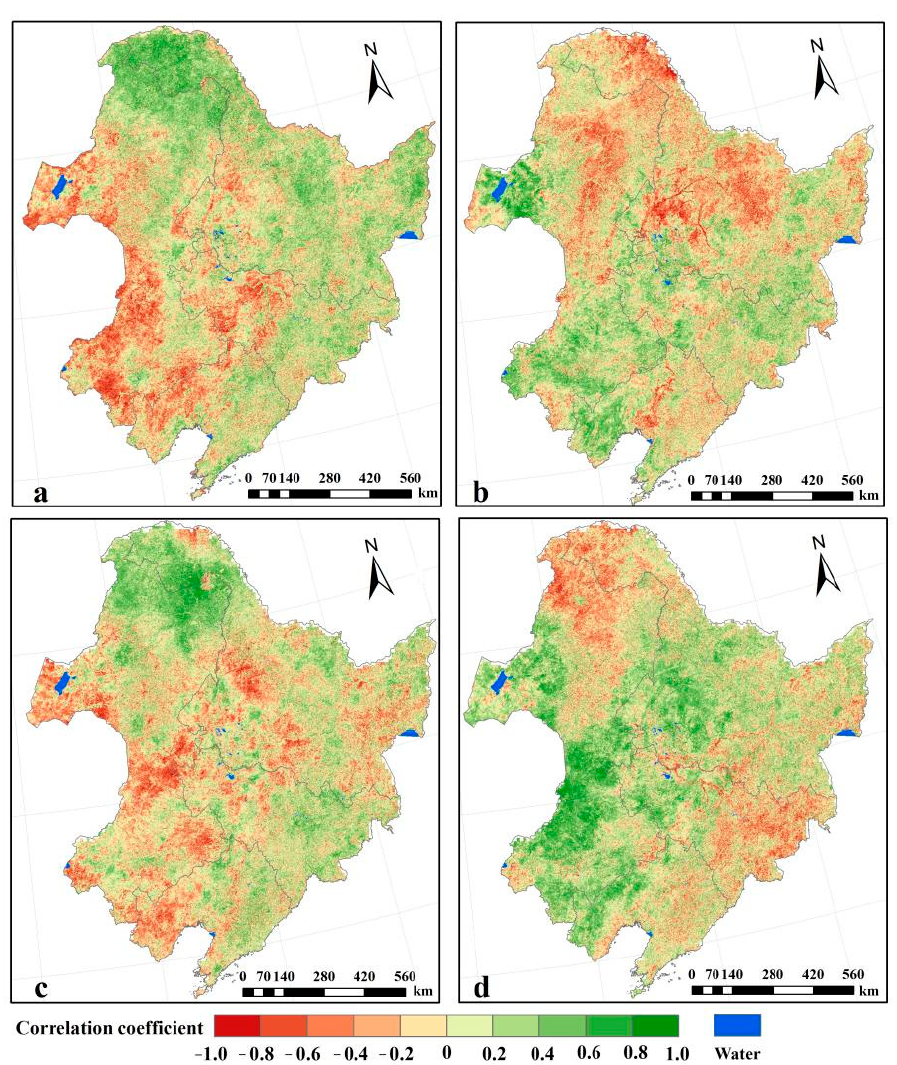
Figure 3. Results of the partial correlation analysis between the vegetation NPP and meteorological factors during 2003 to 2012: ( a ) temperature, ( b ) precipitation, ( c ) solar radiation, and ( d ) relative humidity.